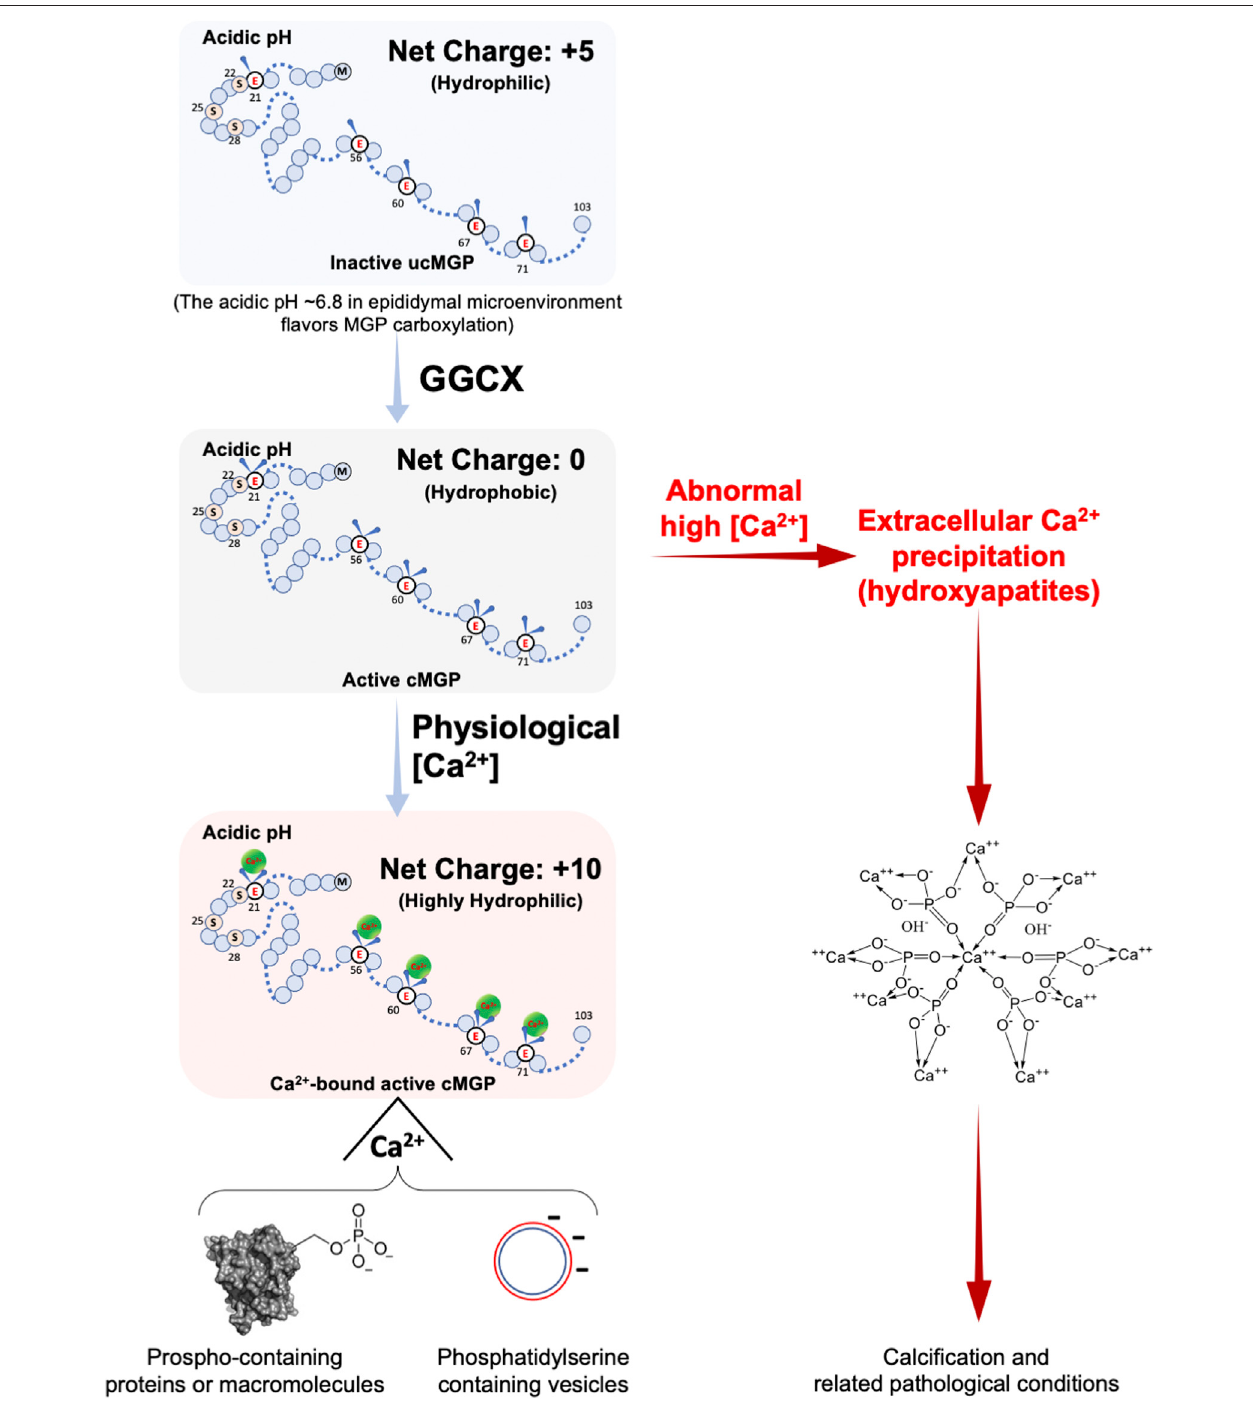
FIGURE 4 | Calcium-dependent chelation property of MGP with or without carboxylation. MGP is a protein composed of 103 amino acids and can be post- translationally modi fi ed by carboxylation and phosphorylation. Uncarboxylated MGP (ucMGP) is an inactive form with an isoelectric point of around 9 (8.8 for rat and 9.6 for humanMGP),which meansthat inanacidicenvironment, theucMGP has anetpositive chargeof fi ve, despite its fi ve γ -glutamate residues, and thus itishydrophilic. When the fi ve γ -glutamate residues are carboxylated to γ -carboxylglutamates by GGCX enzymatic activity, the carboxylated MGP (cMGP) becomes active but is electrically neutral and thus hydrophobic. Intriguingly, the fi ve carboxylated γ -glutamate residues of cMGP bear fi ve negative charges, which favors the chelation of fi ve Ca 2+ ions and form a highly hydrophilic ten-positively-charged cMGP-Ca 2+ compound, facilitating chelation of negative-moiety-bearing molecules under normal physiological conditions, particularly aggregation of organic or inorganic phosphates, or the membrane-embedded phosphatidylserine such as membranes of extracellular vesicles. Dysregulation oftheCa 2+ -bindingproperty ofcMGPresults inectopic Ca 2+ precipitationand abnormalCa 2+ content, whichcausescMGPtobind with hydroxylapatites and thereby precipitation nucleation, a precursor status of promoting matrix calci fi cation and related pathological conditions.